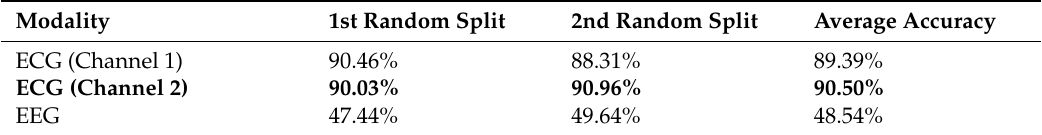
Table 5. Summary results for DREAMER dataset. Highlighted row represents best-performing modality. Modality